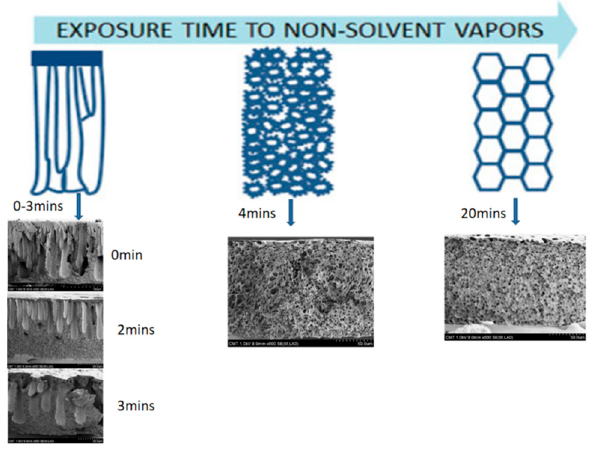
Figure 6. Membrane cross-section structure as a function of time that the cast film was exposed to humid air (20 wt.%, 25 °C and 70% relative humidity), adapted from references [187,192] . [A color figure can be viewed in the online issue, which is available at wileyonlinelibrary.com.].